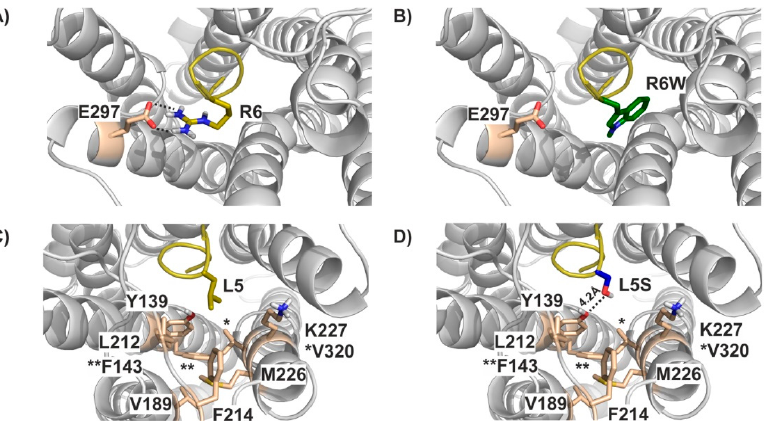
Figure 4. Molecular modelling of DynA_WT, DynA_R6W and DynA_L5S. DynA R6 forms an ionic interaction with E297 ( A ), which is disrupted in the R6W mutant ( B ). ( C ) Dyn L5 is involved in hydrophobic contacts with a range of non-polar KOR residues lining a lipophilic side pocket. Similarly, these interactions cannot be formed with the L5S mutant ( D ). * and ** indicate the position of V320 and F143,